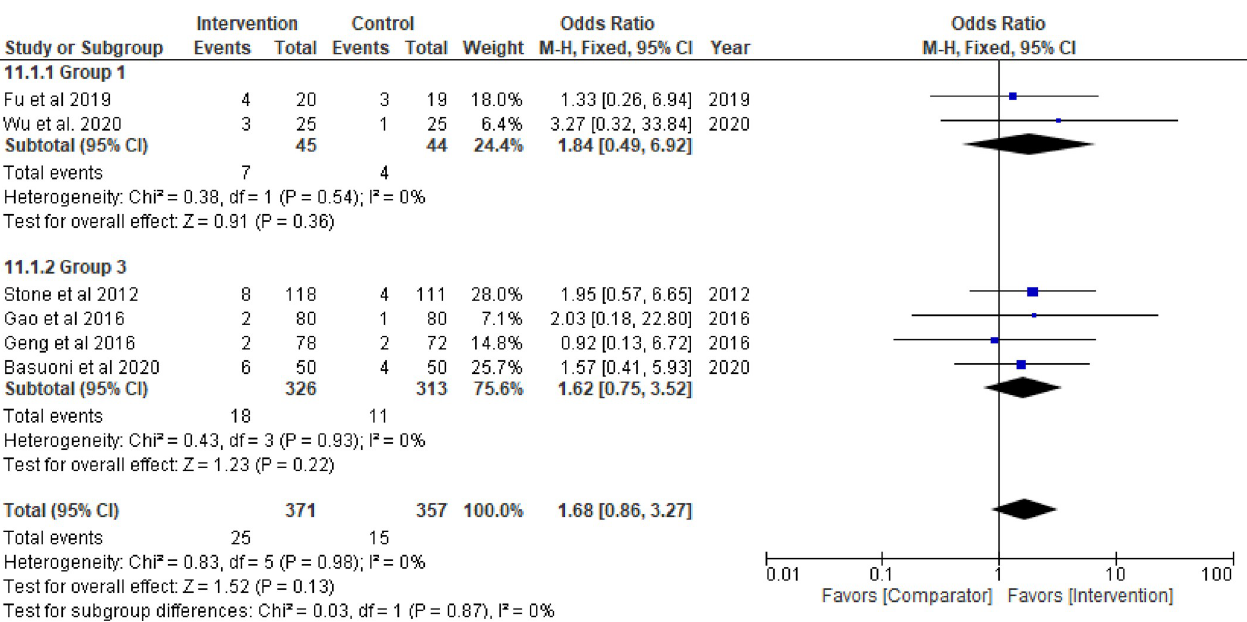
Fig 9. Bleeding. Group 1: Thrombolytic agent; Group 3: GPI plus aspiration thrombectomy (No pooled data for Group 2).